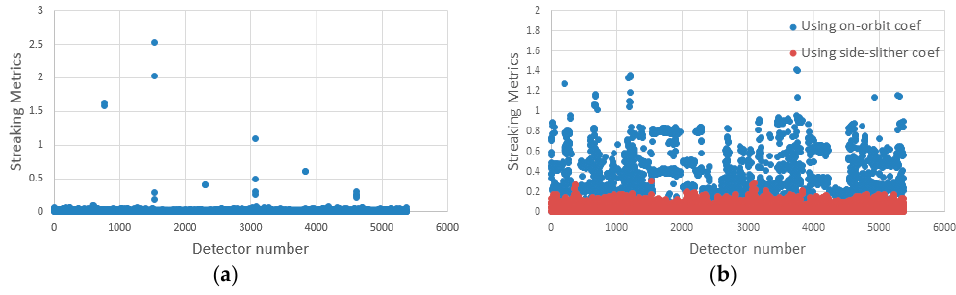
Figure 15. Streaking metrics of desert images. ( a ) Streaking metrics of the raw image; ( b ) Streaking metrics of the images corrected using on-orbit coefficients and side-slither coefficients, respectively.